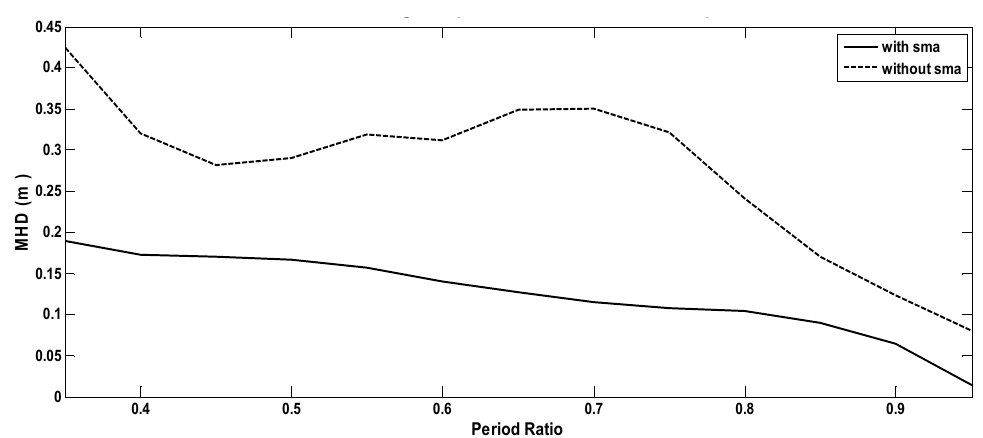
Figure 8: The MHD when using SMA and as–built bridge at various period